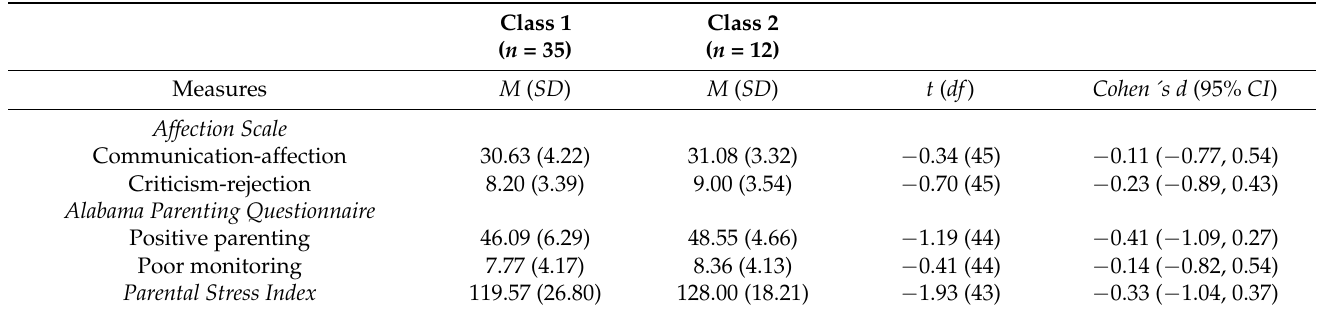
Table 6. Differences between classes on the measured outcome variables.